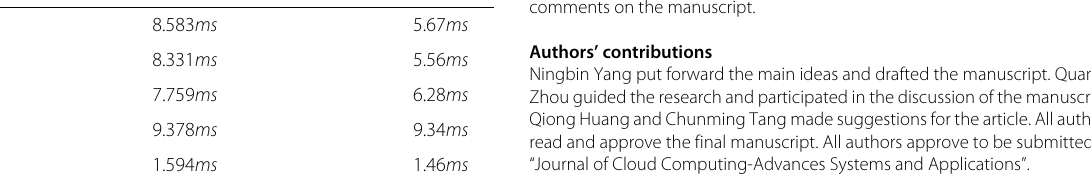
Table 2 Computation cost comparison of single recipient Schemes